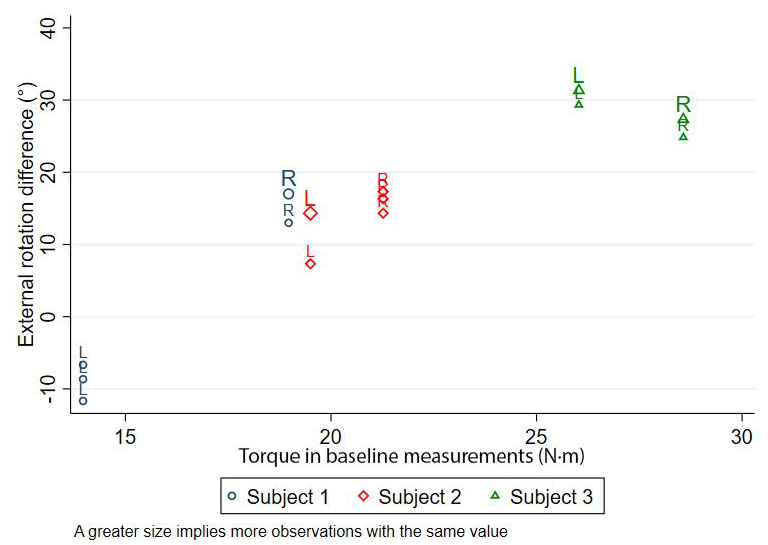
Figure 6. Differences in external rotation between baseline and post-LDTT performance (Test B) in the cadaveric specimens for maximum mean preoperative external rotation values. The values for each arm are shown separately for each of the three subjects (L = left; R = right). Three measurements per arm were recorded for both arms of the cadaveric specimens.